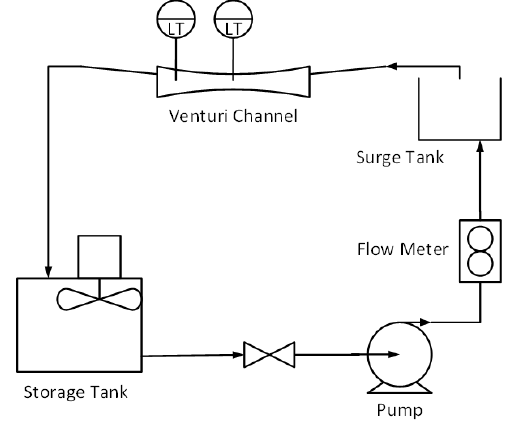
Figure 2: The P&ID diagram of the flow loop of the experimental set up.